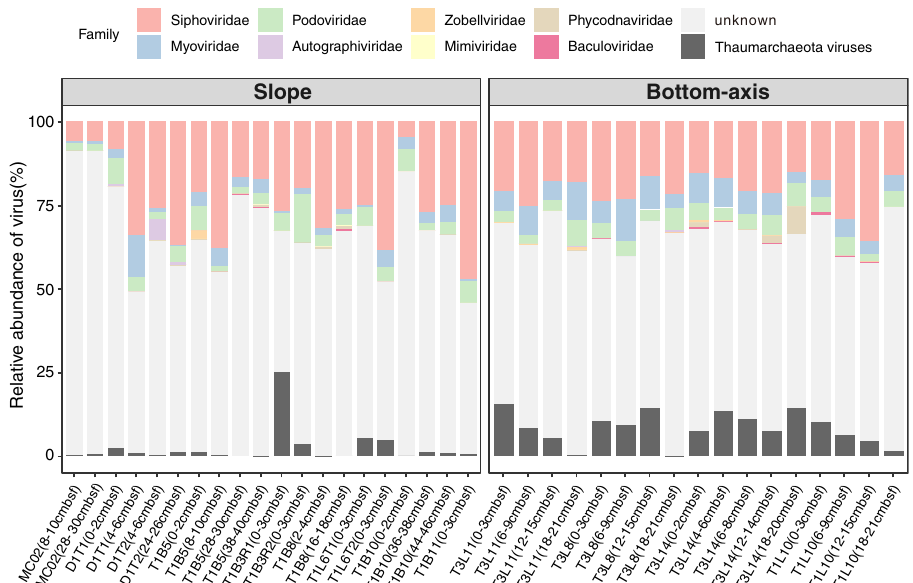
Fig. 3 Relative abundance of viruses (family level) in 37 metagenomes. The relative abundance of vOTUs in each sediment layer was calculated as the normalized coverage of each vOTU divided by the total normalized coverage of the vOTUs in each metagenome. The estimated abundances of vOTUs are summed at family level except for four potential Thaumarchaeota viruses, which are also unclassi fi